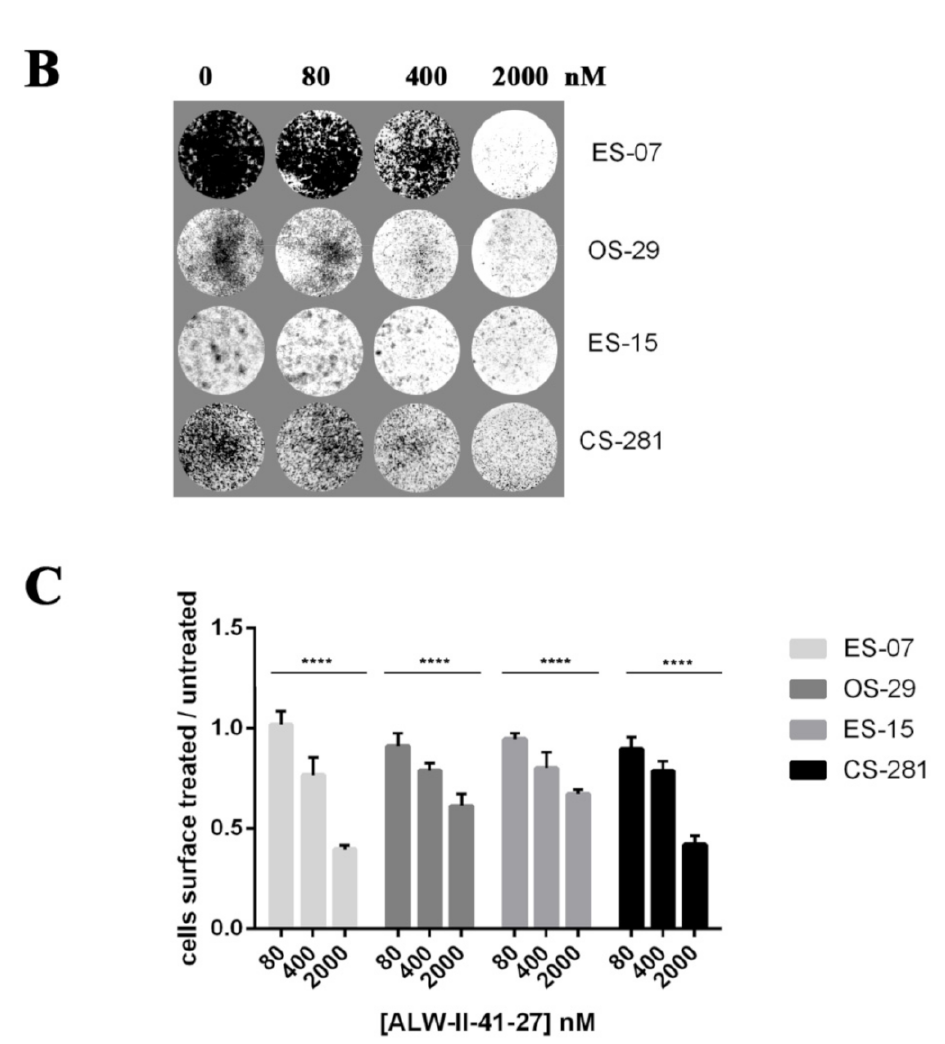
Figure 7. Dose-dependent antitumoral effects of the EphA2 inhibitor ALW II-41-27. ( A ) Cell viability assays and ( B ) cell growth assays after 72 h of treatment with scalar concentration of ALW II-41-27. ( C ) Quantification of the plate surface occupied by viable adherent cells, **** p <